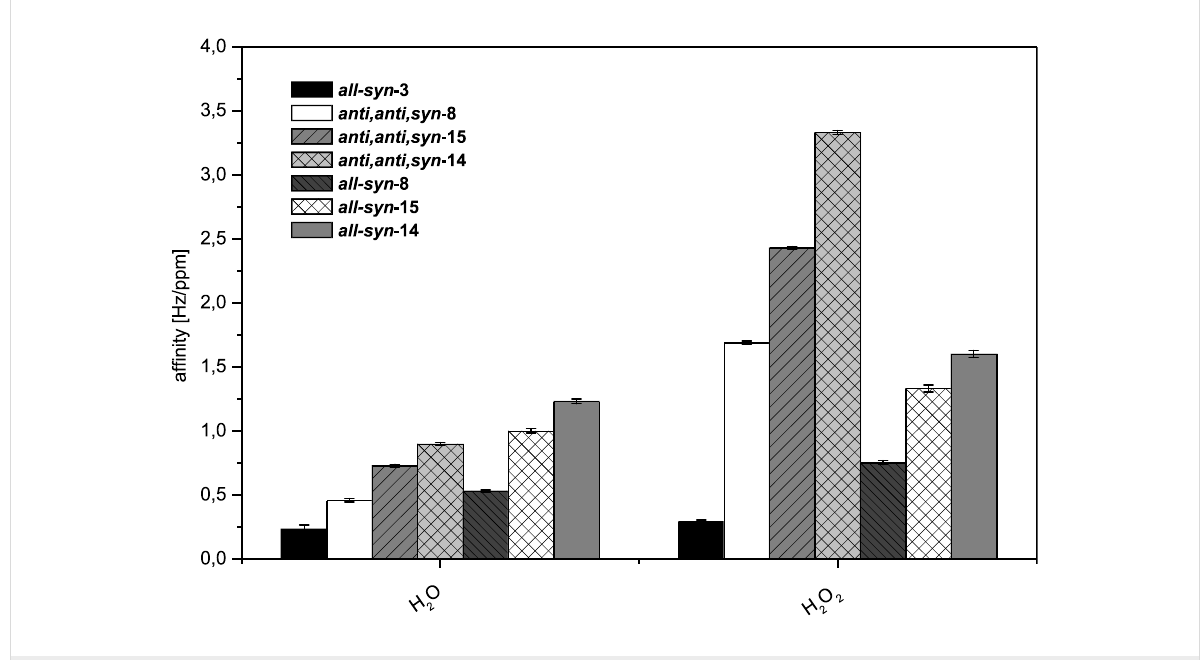
Figure 11: Screening of protic analytes with affinity materials 3 , 8 , 14 and 15